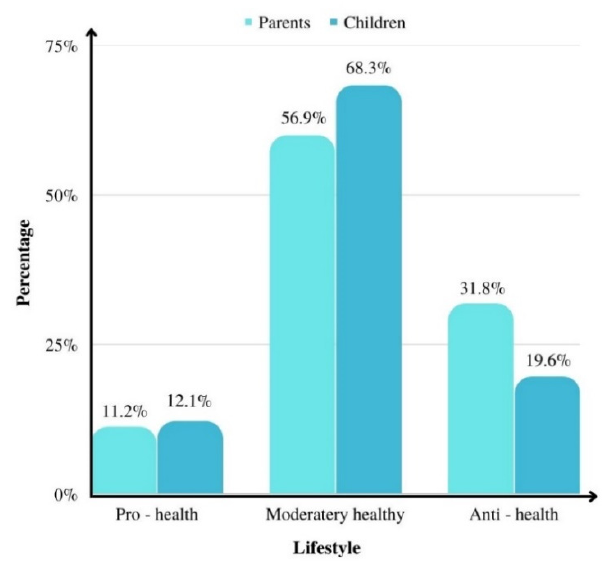
Figure 3. Evaluation of parents’ and children’s lifestyle .